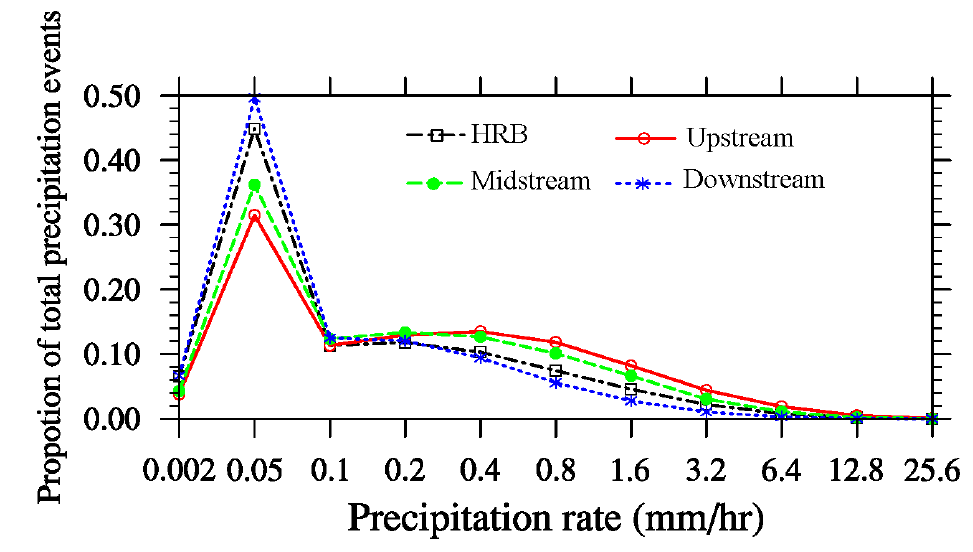
Figure 13. The proportion of all precipitation events with a particular hourly precipitation rate in the HRB, and the upstream, midstream and downstream areas from 2000 to